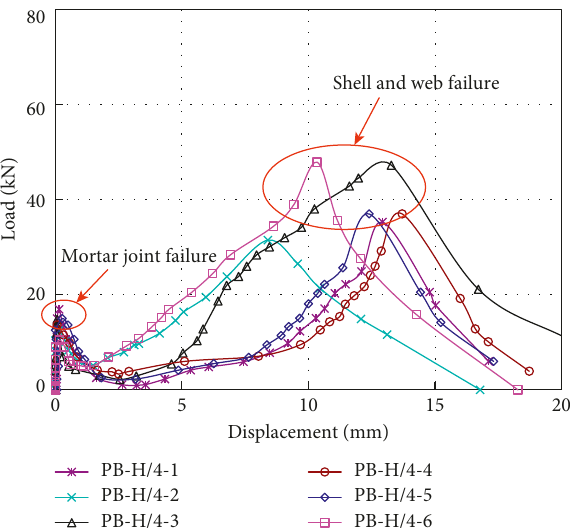
Figure 12: Load-displacement response of group